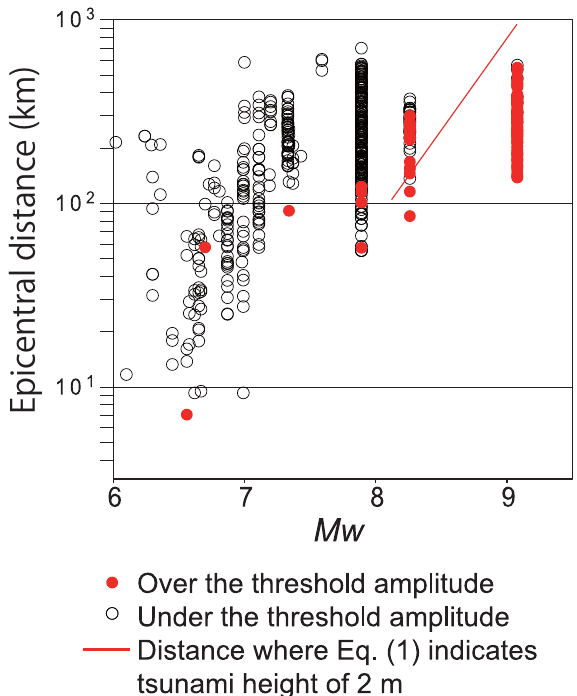
Figure 3. Data distribution of the maximum vertical displace- ment amplitude. Amplitude data which exceed the threshold value (0.081m) are presented by red dots. The red line indicates the dis- tance at which tsunami height is 2m based on the Eq. (1) by Abe (1981).